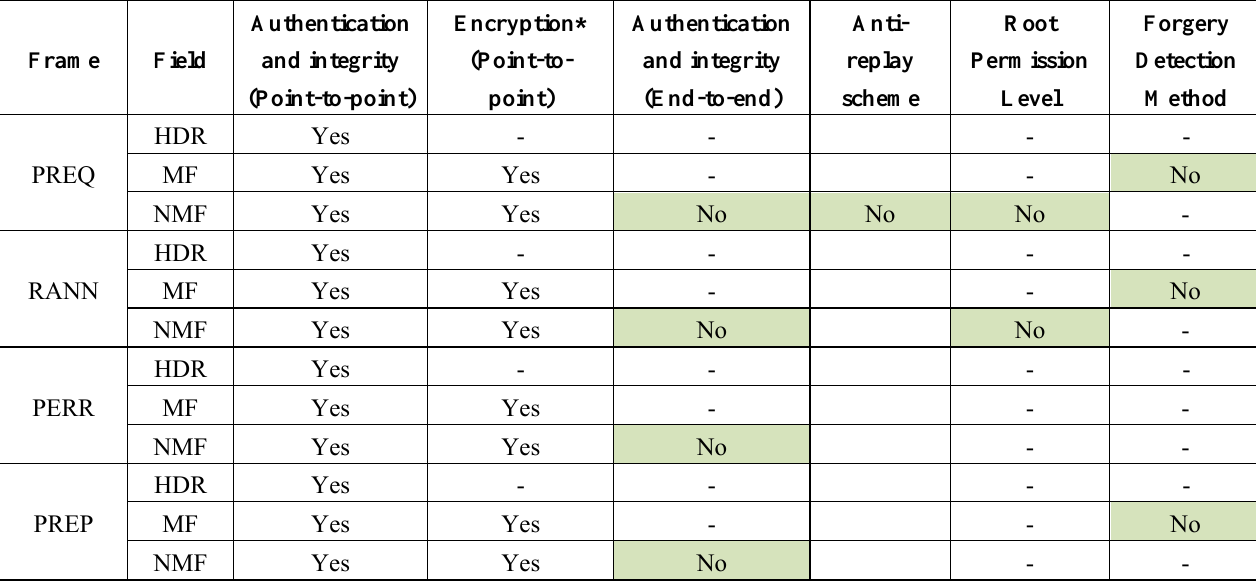
Table 10. Security services provided by CCMP and